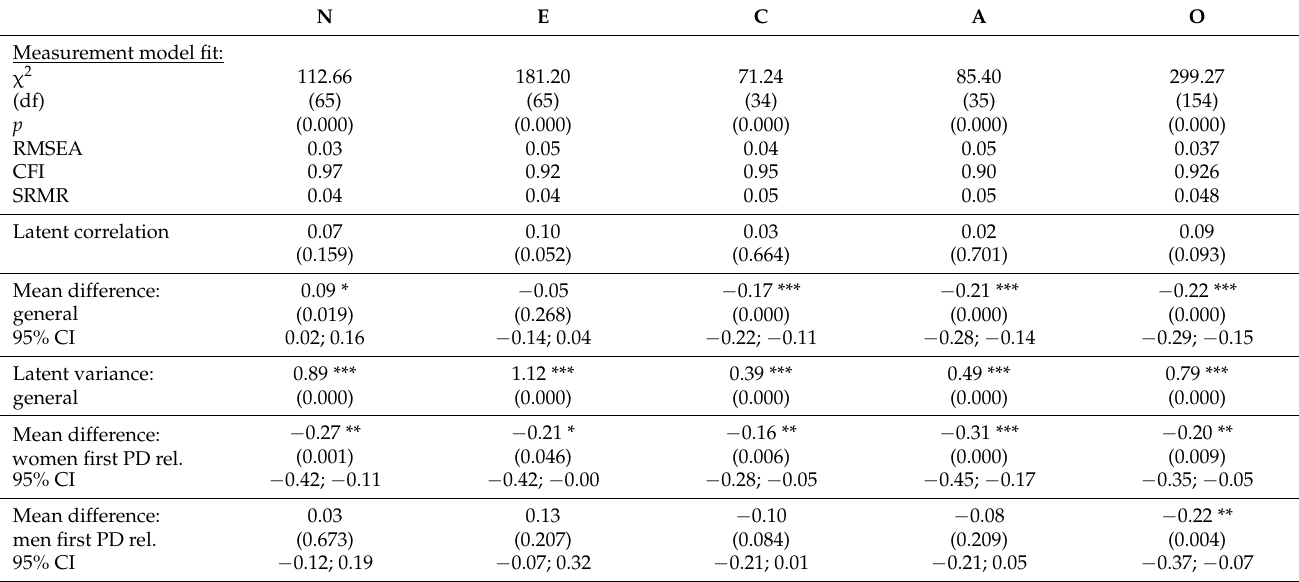
Table 1. Measurement model fit, latent correlations and latent difference scores. Positive mean difference scores indicate that the new partner outscores the